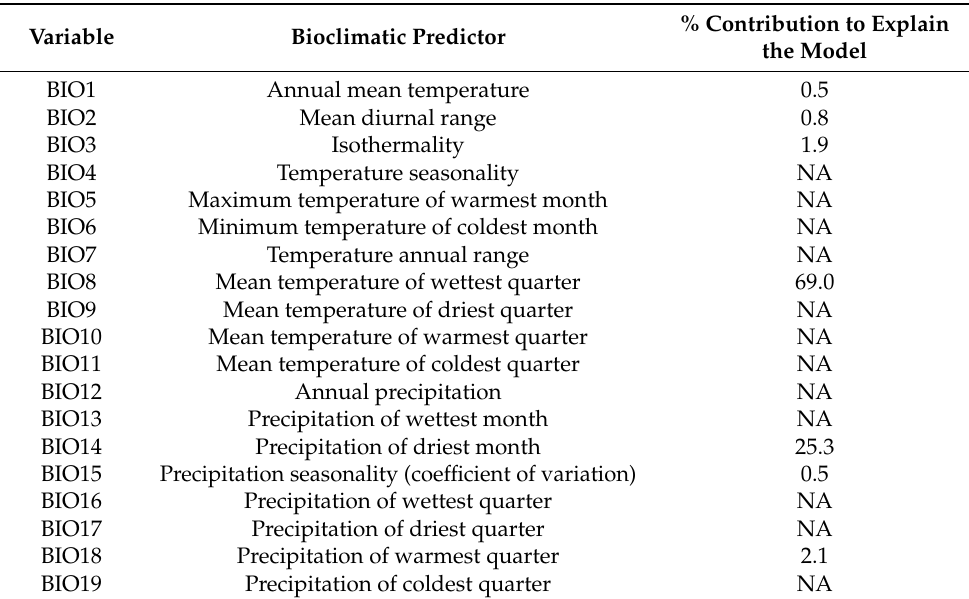
Table 2. Biolimatic variables incorporated in the Tryoza erytreae (Hemiptera: Triozidae) ecological niche modelling in Mexico [47,59]. Variable Bioclimatic Predictor